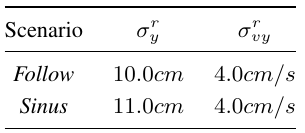
Table 3: Reference system standard deviation for each scenario. The RT systems are mounted on a fixed position in the back of each car and the bore-sight-alignement has been calibrated. As shown in Fig. 5, the position offset between the RT system for the ego vehicle ( RT ego ) and the target vehicle ( RT t ), is reduced to the position offset, as seen from the scanner. For every object the handed position refers to the reference point RP h , where h denotes eight possible positions - the four edges of the rear/front and left/right side as well as the four points in the middle of each side (E.g. RP rl points to the rear left RP). Time-reference is given, as the RT provides the UTC stamp via the NTP interface.